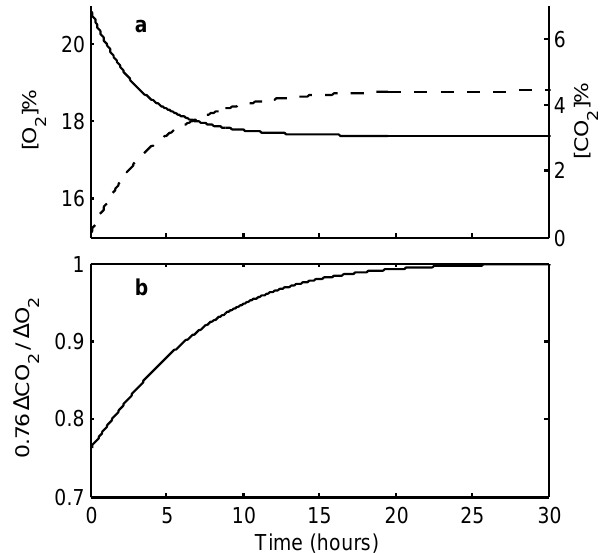
Fig. 2. (a) Modeled O 2 (solid line) and CO 2 (dashed line) concen- trations, and (b) the relationship between the increase in CO 2 and the decrease in O 2 (multiplied by the ratio of these gases diffusivi- ties in air, which is 0.76), as produced by a 1-box numerical